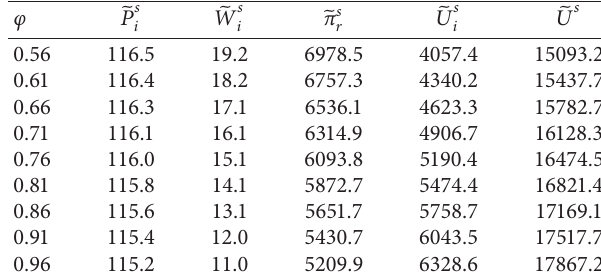
Table 3: Effect of variation in other parameters when manufac- turers are peer-induced to fairness